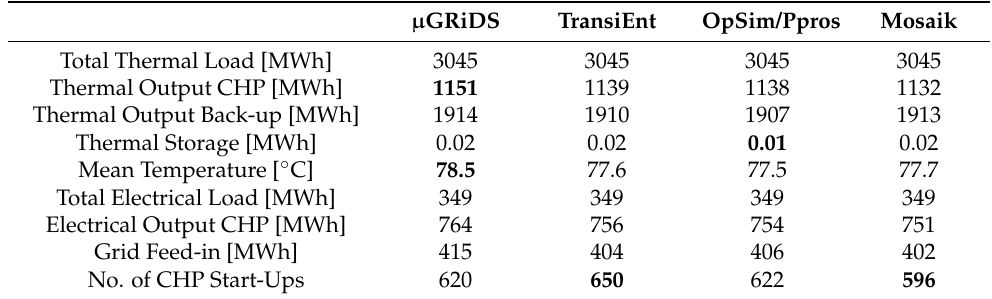
Figure 3. Mean tank temperature for the different models in winter ( top ), transition ( mid ), and summer ( bottom ) seasons. Table 7. Output indicators for the models under study. Significant deviations are